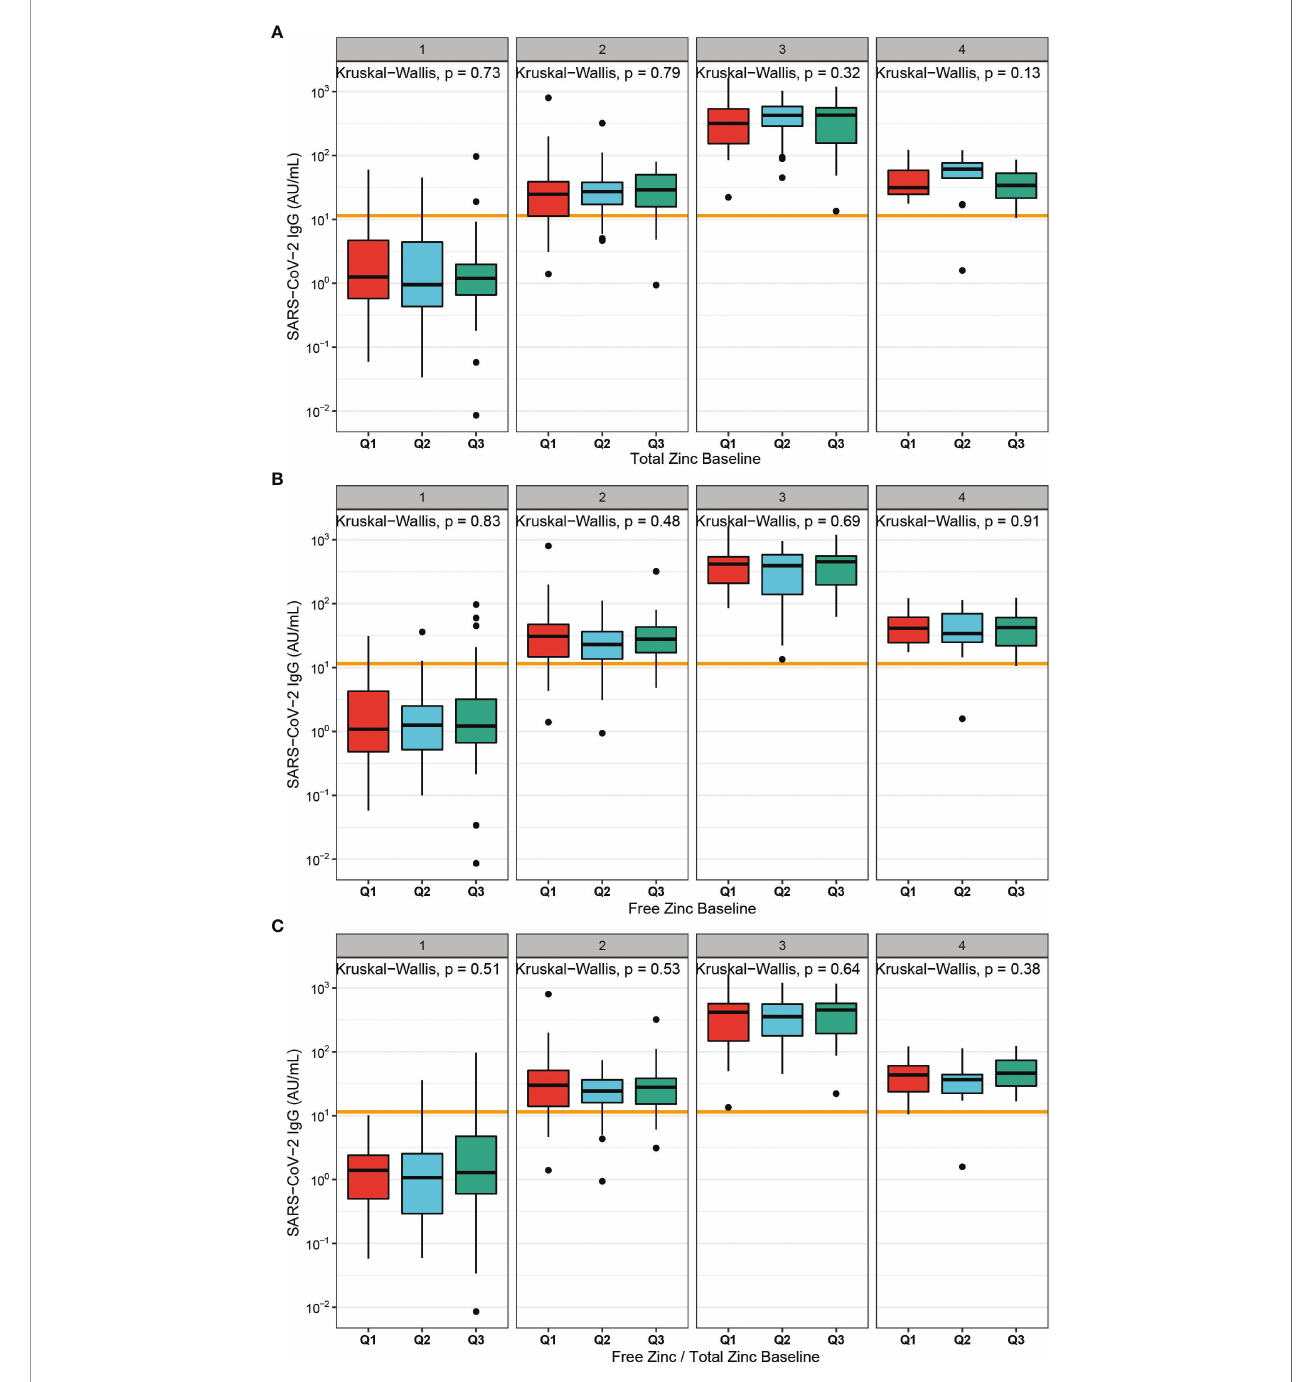
FIGURE 3 | Baseline Zn status in relation to antibodies to SARS-CoV-2 after vaccination. (A) Total serum Zn was categorized into tertiles at time of fi rst vaccination (Q1 < 764.3 µg/L; Q2 < 852.4 µg/L; Q3 > 852.4 µg/L), and plotted against SARS-CoV-2 antibody concentrations. No signi fi cant differences were observed between the groups. (B) Free Zn was divided into tertiles at fi rst vaccination (Q1 < 0.51 nM; Q2 < 0.59 nM; Q3 > 0.59 nM). Again, no signi fi cant differences in humoral vaccination response over time was detected. (C) The free Zn/total serum Zn ratio was calculated and used to classify the samples into tertiles (Q1 < 4.09; Q2 < 4.81; Q3 > 4.81). No signi fi cant difference in the concentrations of antibodies to SARS-CoV-2 were detected across the tertiles. Two-sided Kruskal-Wallis test was used to assess